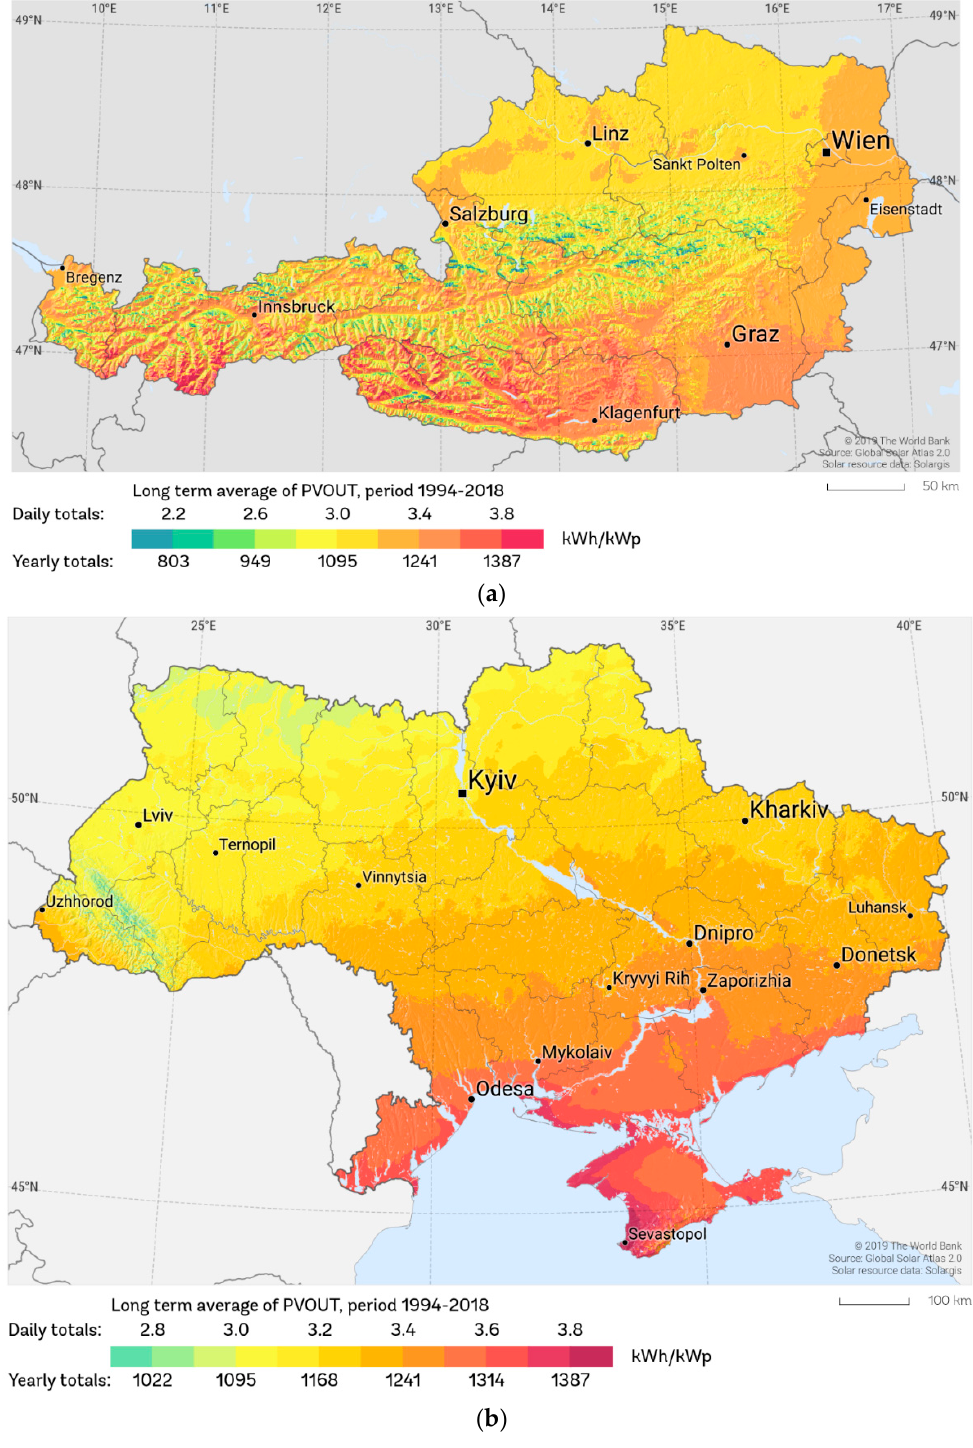
Figure 1. ( a ) Photovoltaic power potential of Austria [9]. ( b ) Photovoltaic power potential of Ukraine [9].